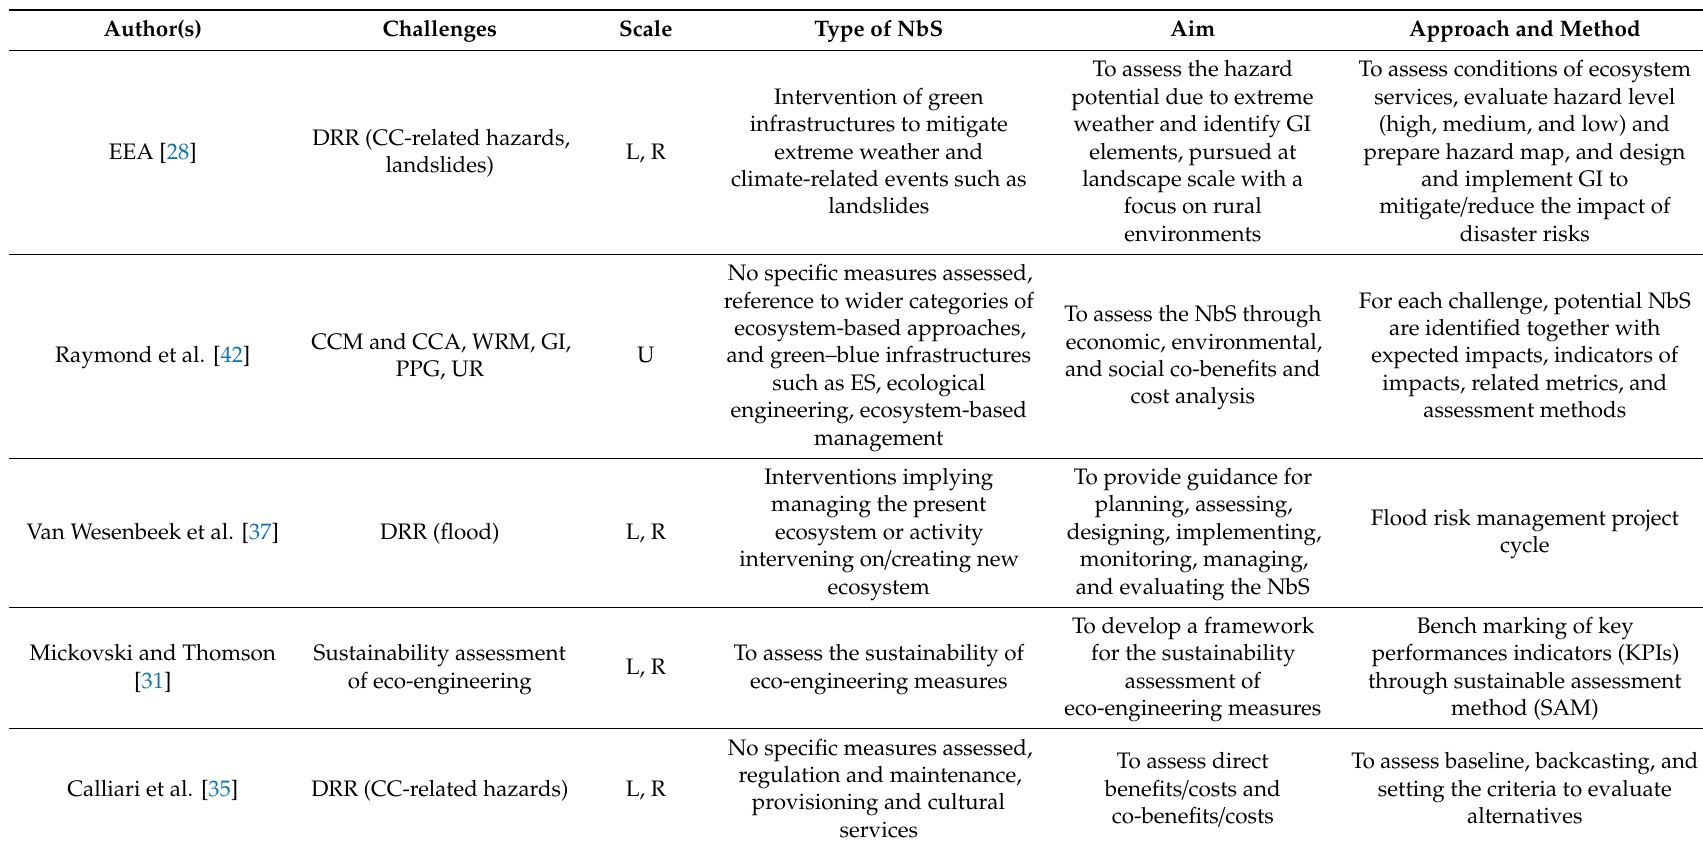
Table 1. Summary of key characteristics of nature-based solutions (NbS) assessment